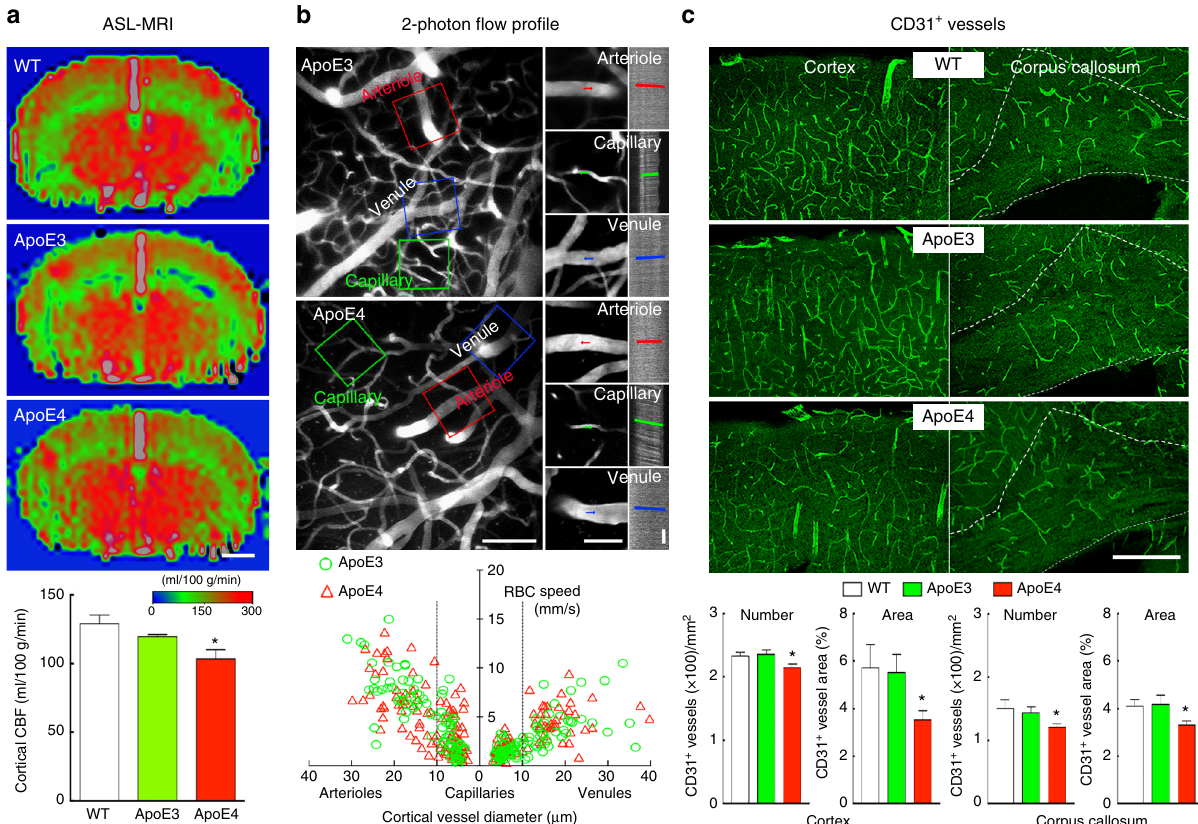
Fig. 1 Reduced cortical CBF and vascular density in ApoE4-TR mice. a Neocortical CBF, assessed by ASL-MRI, is lower in ApoE4-TR mice, compared to WT and ApoE3 mice. Scale bar = 1 mm. b . RBC speed in neocortical vessels (depth = 200 µ m) in ApoE3-TR and ApoE4-TR mice assessed by 2-photon microscopy after injection of FITC-labeled dextran to label the vasculature. Top two images show the microvasculature in ApoE3 and ApoE4 mice. The colored rectangles indicate the location of the vessels (arterioles, capillaries, and venules) in which line scans were obtained to determine RBC speed (right panels). The bottom graph shows the RBC speed measured by line scans as function of the vessel diameter: arterioles (>10 µ m) to the left, capillaries in the middle ( ≤ 10 µ m; placed on arteriole or venule side depending on whether they were topologically closer to an arteriole or venule) and venules (>10 µ m) to the right (ApoE3 n = 166 vessels in four mice, ApoE4 n = 197 vessels in four mice). Scale bars are 100 µ m, 50 µ m, 100 ms, respectively, for the large, small, and line scan images. c CD31 + microvessels are reduced in ApoE4 mice both in neocortex and CC. Scale bar = 250 µ m. The ApoE3-TR mice did not differ from WT mice ( p > 0.05). Data are expressed as means ± SEM. N = 5/group in a and c ; * p < 0.05; one-way ANOVA and Tukey ’ s